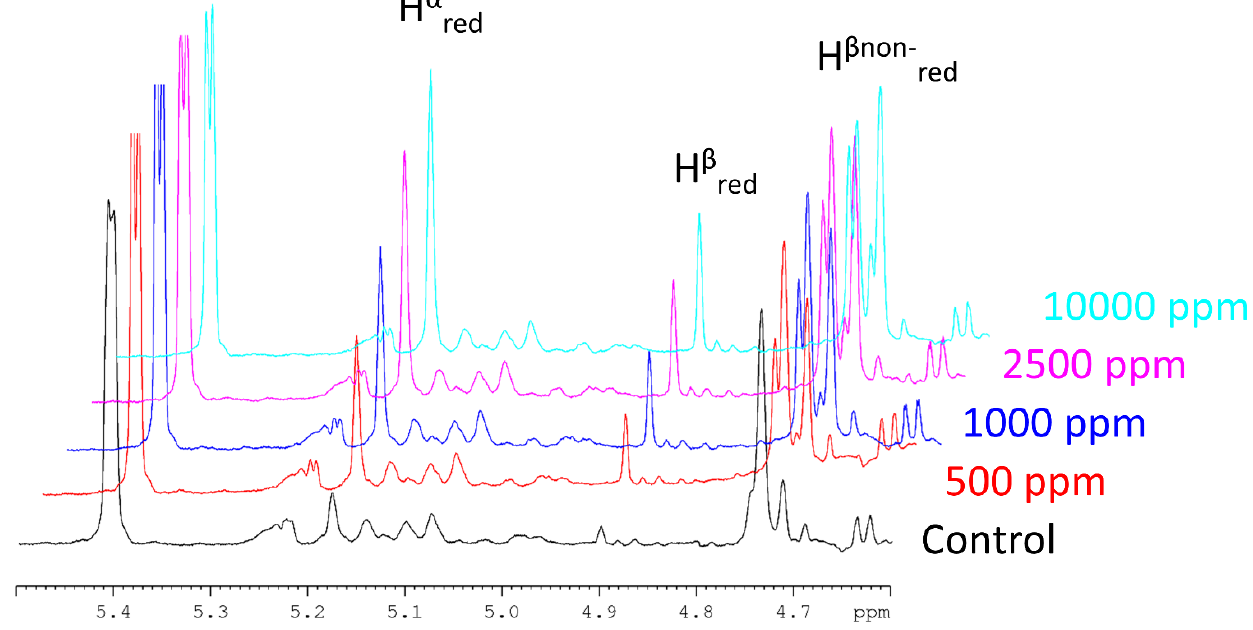
Figure 2. 1 H-NMR spectra of anomeric region of mannan. The control sample is shown in black. Colored spectra show the sample after treatment with different concentrations of B. subtilis